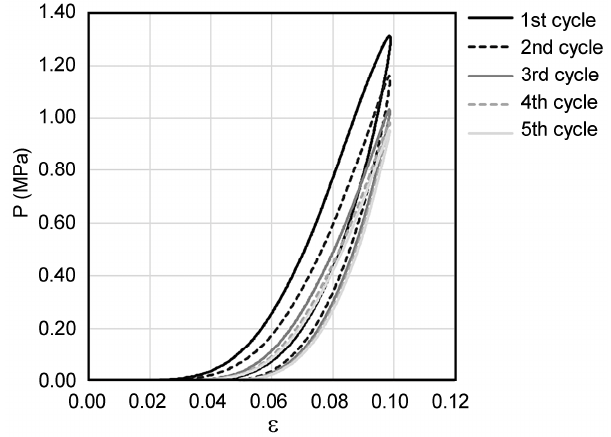
Figure 3. Mechanical response of a PF sample, in terms of nominal stress P vs. nominal strain ε , during five loading–unloading cycles at 10% strain.